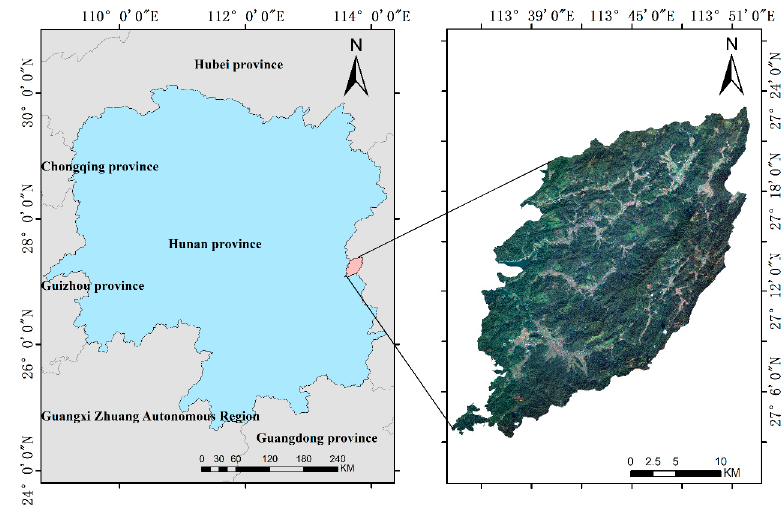
Figure 1. Location map of the study area.